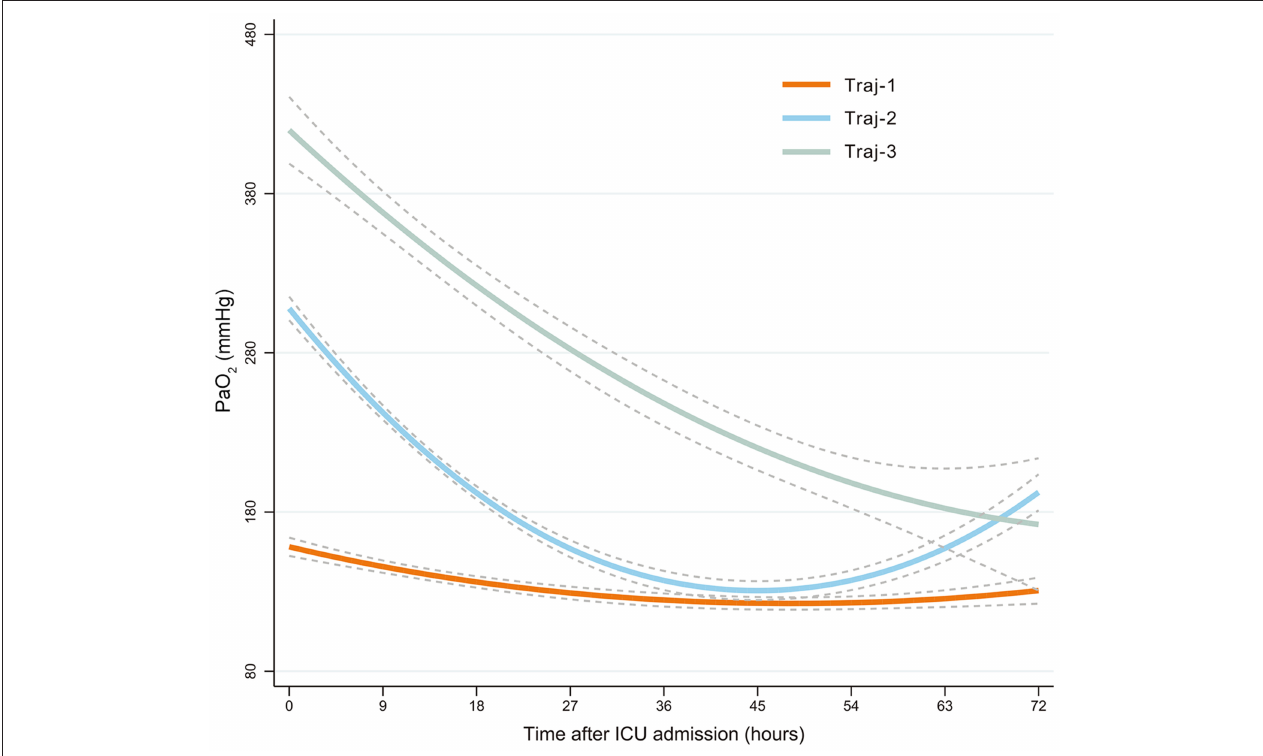
FIGURE 1 | PaO 2 -based trajectories of patients with HBI. Traj-1 (mild hyperoxia), patients with mild hyperoxia during the 72h following admission to ICU; Traj-2 (transient severe hyperoxia), patients with high PaO 2 at ICU admission that rapidly decreased to mild hyperoxia; and Traj-3 (persistent severe hyperoxia), patients with persistent high PaO 2 levels within 72h after ICU admission. Group-based trajectory modeling was used to establish these PaO 2 trajectories. PaO 2 , oxygen partial pressure; HBI, hemorrhagic brain injury; ICU, intensive care unit.